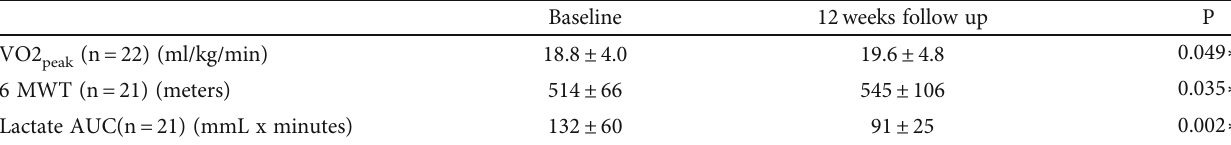
Table 2: Di ff erence from baseline to 12 weeks, all exercise modalities pooled.